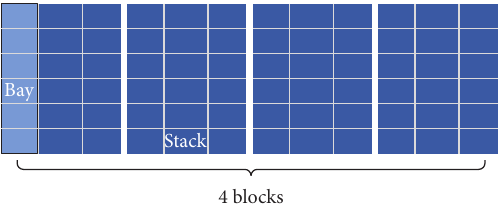
4 Figure 2: The top view of yard space.